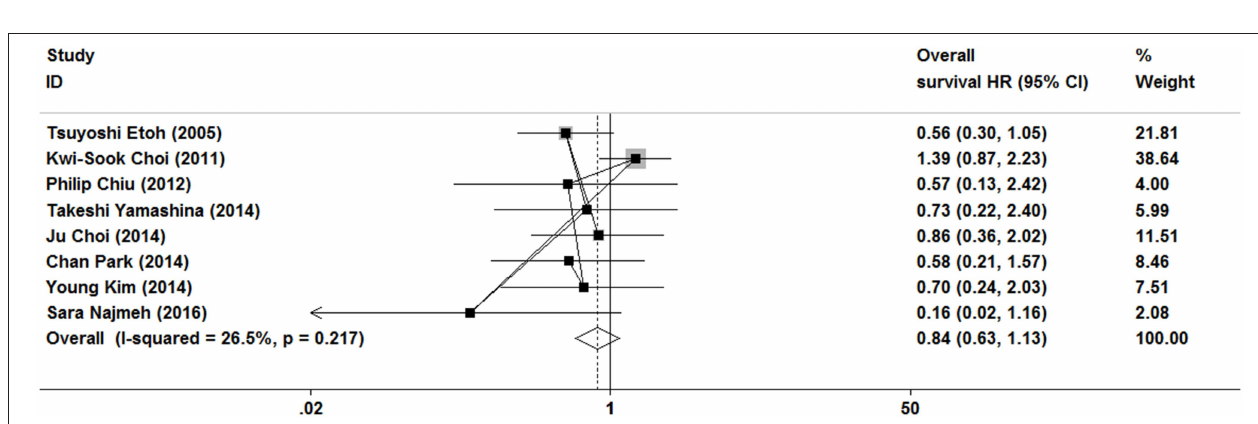
FIGURE 7 | Meta-analysis on overall survival, overall survival did not differ between ER and gastrectomy treatments.